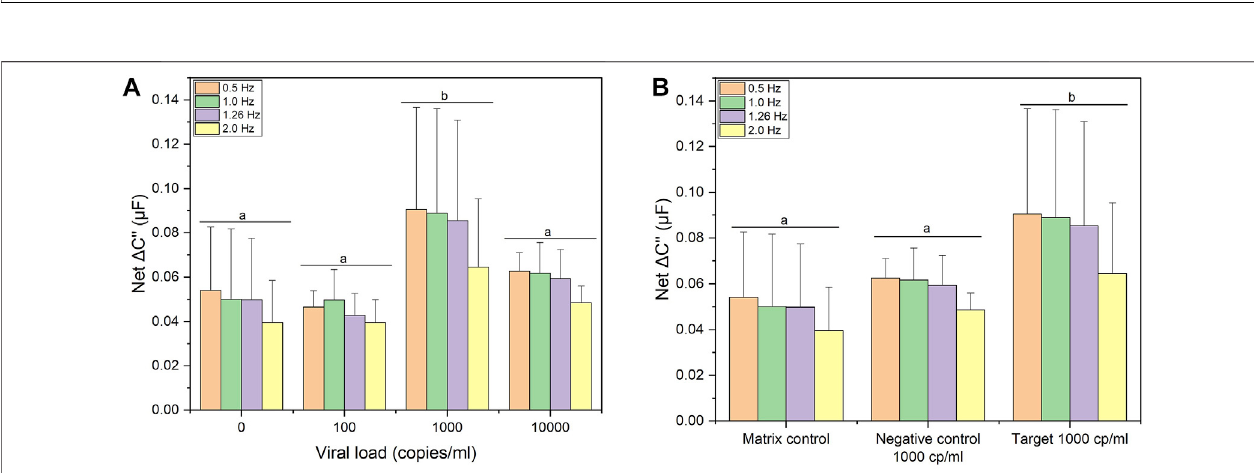
FIGURE 4 | Electrochemical detection studies. (A) Signal response following incubation with 0, 100, 1000, and 10000 copies/mL of UV-attenuated SARS-CoV-2 Deltavariant. (B) Signalresponsefollowingincubationwithclinicalrelevantviralload(1000copies/ml)ofUV-attenuatedSARS-CoV-2Deltavariant;negativecontrol:UV- attenuated human coronavirus (OC43) and matrix effects (pooled saliva target-free). Four optimum cutoff frequencies are shown for each data set. Error bars represent standard deviation from the mean measurement ( n = 12 for matrix control; n = 3 for negative control and target). Same letters represent groups with no signi fi cant difference ( p <